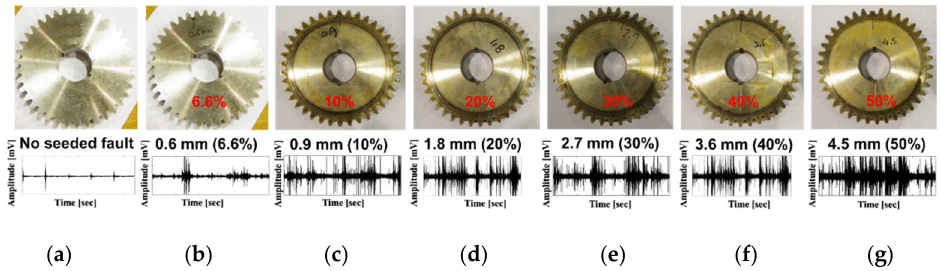
Figure 2. The defect states of the gear wheel and examples of vibration signals at a rotation speed of 600 RPM: ( a ) no seeded fault, normal gear, ( b ) tooth cut 6.6% (0.6 mm), ( c ) tooth cut 10% (0.9 mm), ( d ) tooth cut 20% (1.8 mm), ( e ) tooth cut 30% (2.7 mm), ( f ) tooth cut 40% (3.6 mm), and ( g ) tooth cut 50% (4.5 mm), respectively. Table 1. A detailed description of the MTCG defect types and dataset.